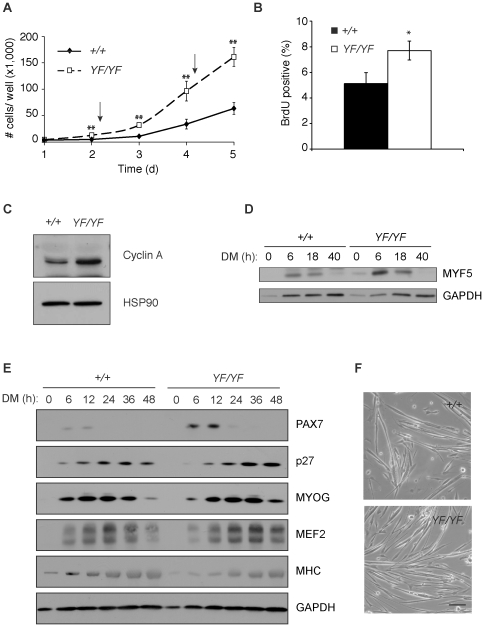
Activated CREB promotes myoblast proliferation and differentiation.A) Growth curve assay of Creb+/+ and CrebYF/YF myoblasts over 5 days. Arrows, medium added. **, p<.01 between genotypes. B) Percent of BrdU-positive nuclei in asynchronous myoblast cultures. Means of 10 fields among 3 replicates. *, p<.05. C) CyclinA and HSP90 protein in asynchronous myoblasts. D) Myf5 and GAPDH control in differentiating Creb+/+ and CrebYF/YF myocytes. E) Muscle-specific proteins in Creb+/+ and CrebYF/YF myocytes after the indicated times in differentiation medium (DM). MYOG, myogenin; MHC, myosin heavy chain; GAPDH loading control. F) Phase contrast images of 2 day differentiated Creb+/+ and CrebYF/YF myotubes. Bar, 100 µm.